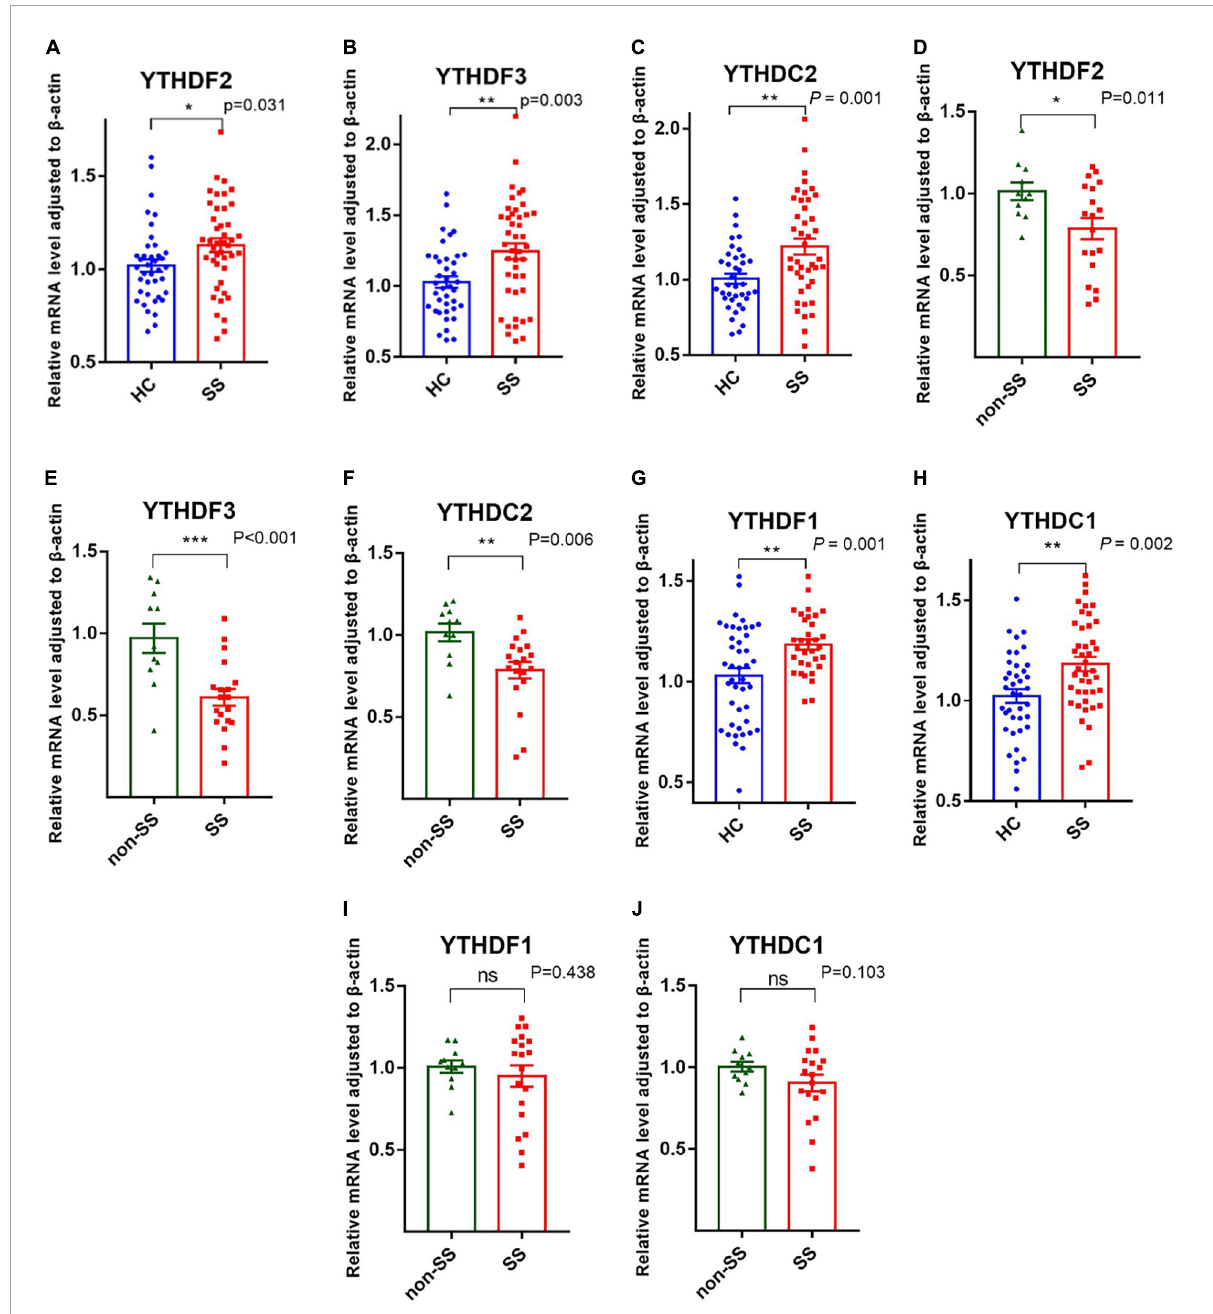
FIGURE3 Messenger RNA (mRNA) levels of N6-methyladenosine (m6A) readers in peripheral blood mononuclear cells (PBMCs) from patients with primary Sjögren’s syndrome (pSS), patients with non-SS sicca, and healthy controls (HCs). (A–F) The mRNA levels of YTHDF2, YTHDF3, and YTHDC2 in PBMCs from patients with pSS were higher than that of HCs but lower than that of patients with non-SS sicca. (G–J) The mRNA levels of YTHDF1 and YTHDC1 in PBMCs from patients with pSS were higher than HCs. No significant difference was found in the expression of YTHDF1 and YTHDC1 between patients with pSS and patients with non-SS sicca. * p < 0.05, ** p < 0.01, and *** p < 0.001.